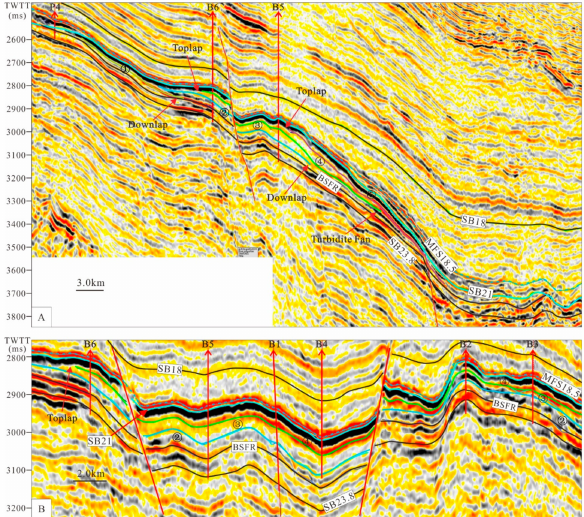
Figure 5. Seismic profile corresponding to sequence and sedimentary system of the Panyu low uplift and Baiyun sag in Pearl River Mouth Basin (location of section is given in Figure 1B): ( A ) Seismic facies characteristics with oblique progradational configuration in the depositional trends. ( B ) Seismic facies characteristics with divergent fill in the vertical depositional trends. Note the seismic profile is below the shelf break at 21 Ma and seaward.